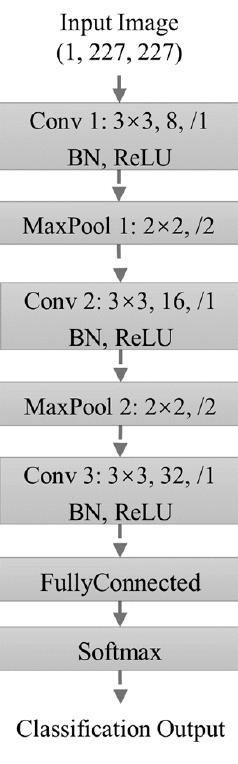
Figure 4. CNN Structure Diagram.